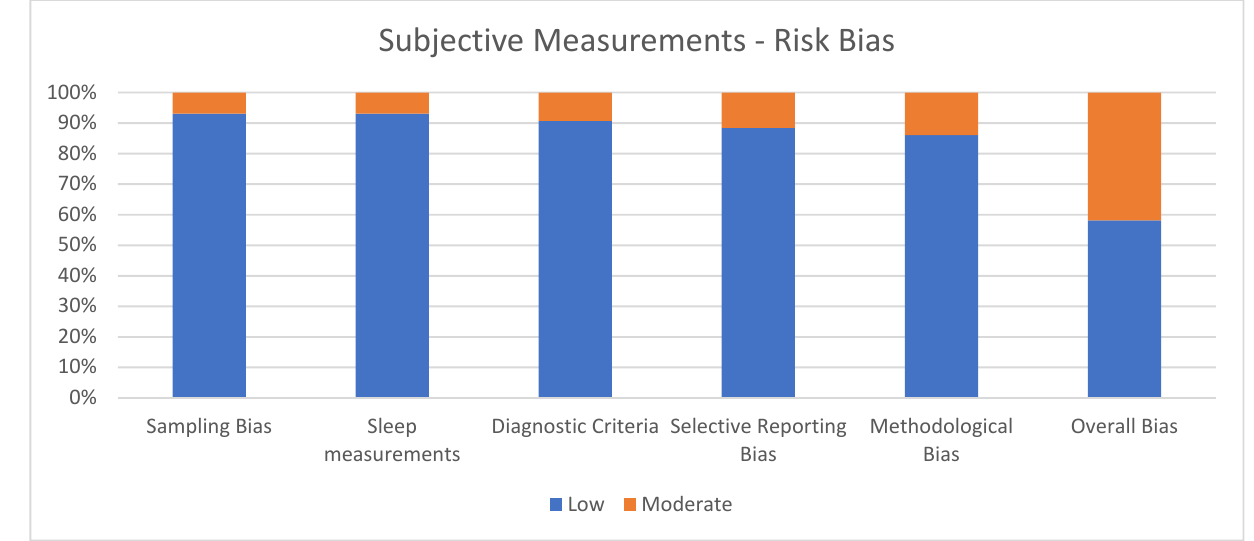
Figure 2. Subjective measurements.